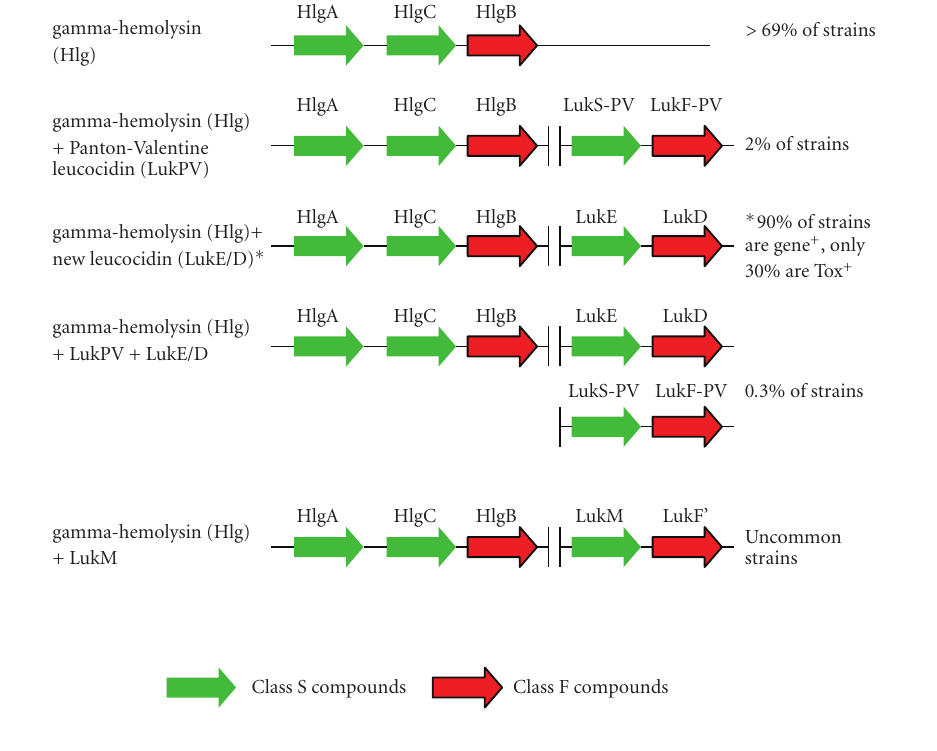
Figure 1: Distribution of the genes expressing leucotoxins of S aureus.